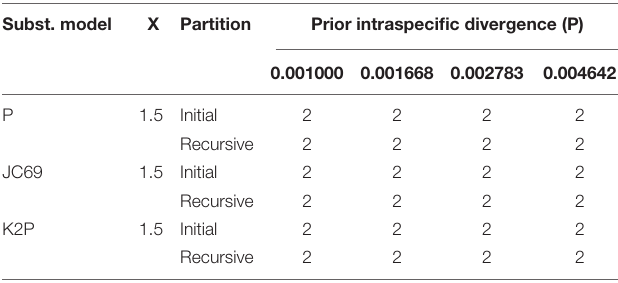
TABLE 2 | The number of putative species recognized by Automatic Barcode Gap Discovery (ABGD) analyses among 51 complete plastomes using three distance metrics.